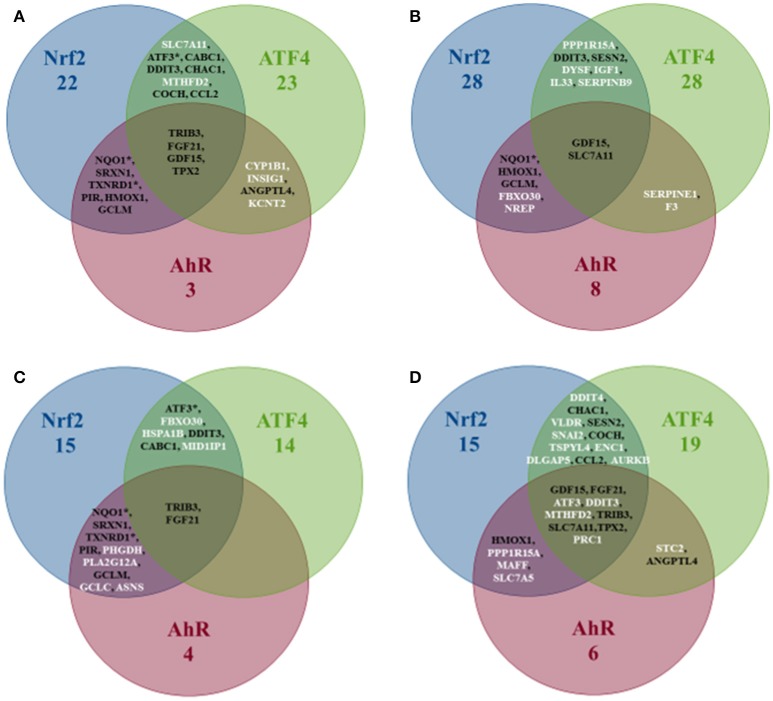
Venn diagram of the number of genes per pathway's stratified signatures and names of genes of overlapping zones. Categories: (A) All liver data, (B) Rat Liver in vitro data, (C) Rat Liver in vivo data, (D) Human Liver in vitro data. *Refers to genes that were known to be part of the same overlapping zone according to Supplement Table 1 lists. White is the color of gene names that appear in an overlapping zone of only one of the four categories studied, and black is the color of gene names that appear in more than one category (two, three or four).